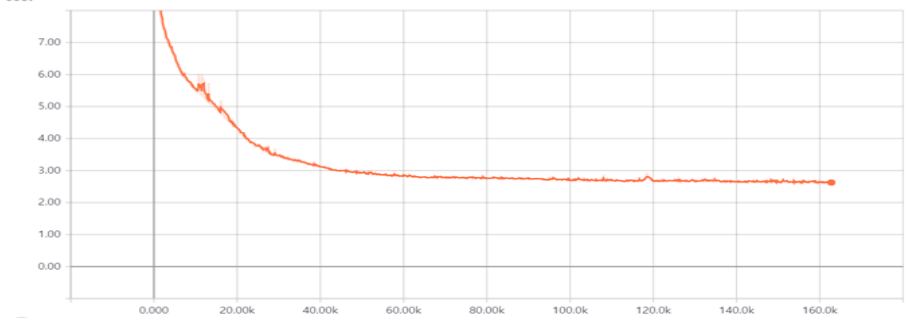
Figure 14. Cost analysis based on the training results of the recurrent neural network model. Table 16. Root mean squared error (RMSE) values of the Long Short-Term Memory (LSTM) and Gated Recurrent Unit (GRU) models.